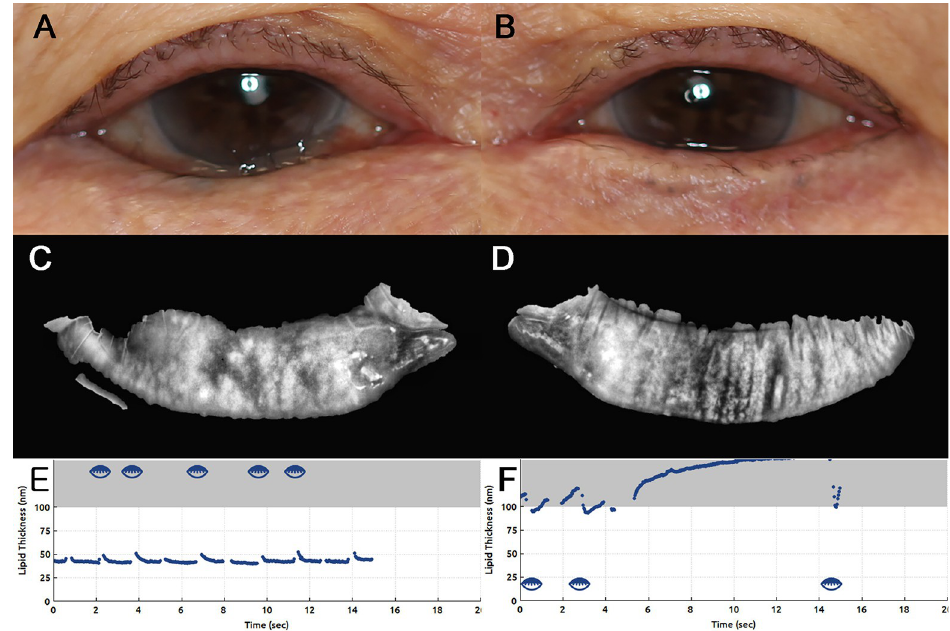
Fig 1. An 82-year-old woman with unilateral lower eyelid marginal entropion showed asymmetric meibomian gland profiles. (A, B) The right lower eyelid had marginal entropion over the entire length, while the left had no entropion. (C, D) Meibomian gland dilation and dropout were observed in the right lower eyelid (meibomian gland loss: 17.7% in the right eye vs. 7.0% in the left eye). (E, F) Average lipid layer thickness was thinner in the right eye (43 nm vs. > 100